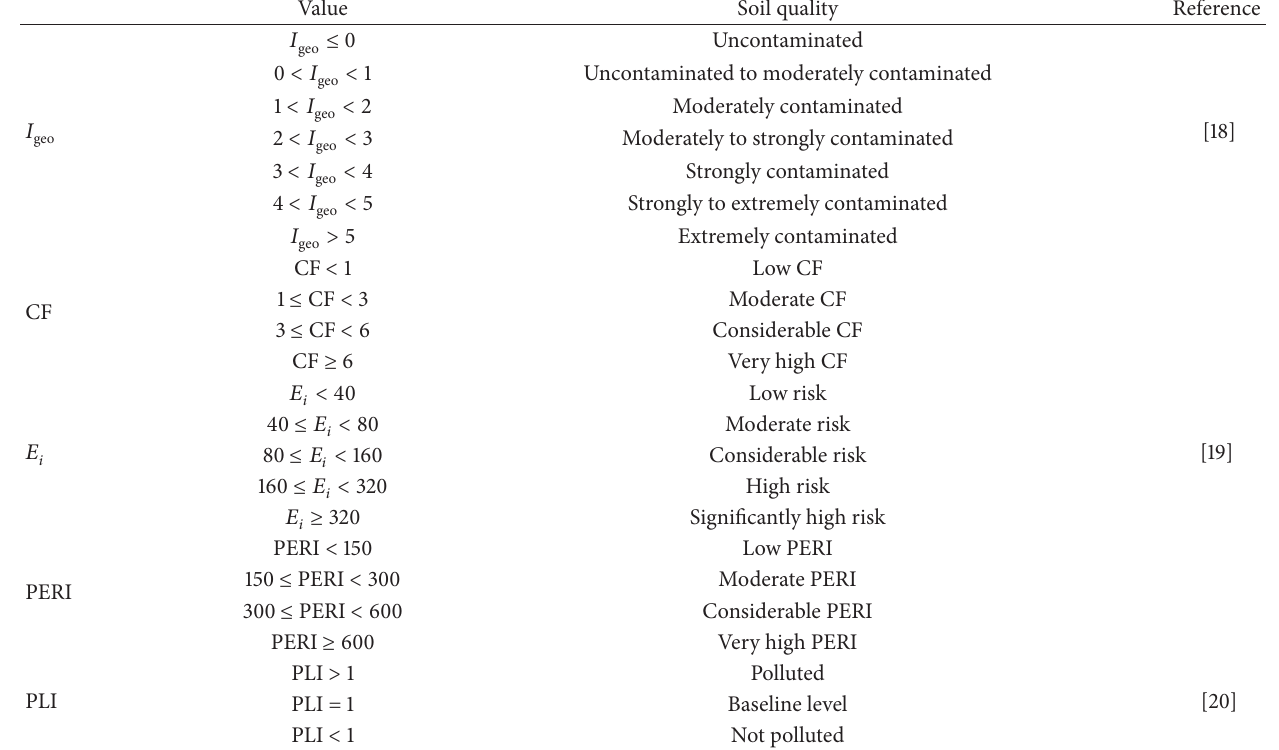
, CF, 𝐸 𝑖 , PLI, and geo